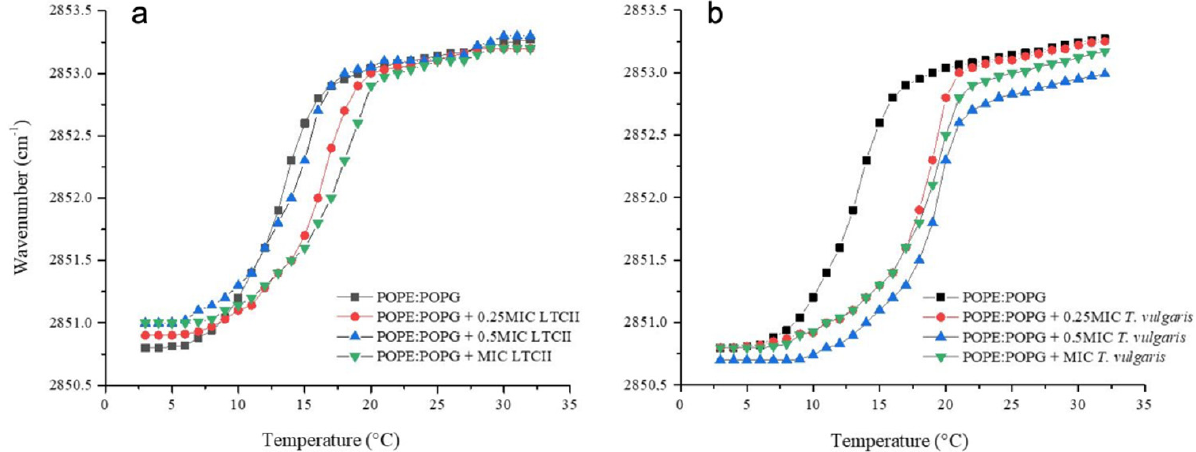
Figure 6. Peak positions of the symmetric stretching vibration bands of the methylene groups as a function of temperature. E. coli representative model membrane (POPE/POPG, 70:30) in the presence of different concentrations of ( a ) LTC II and ( b ) TV EOs.